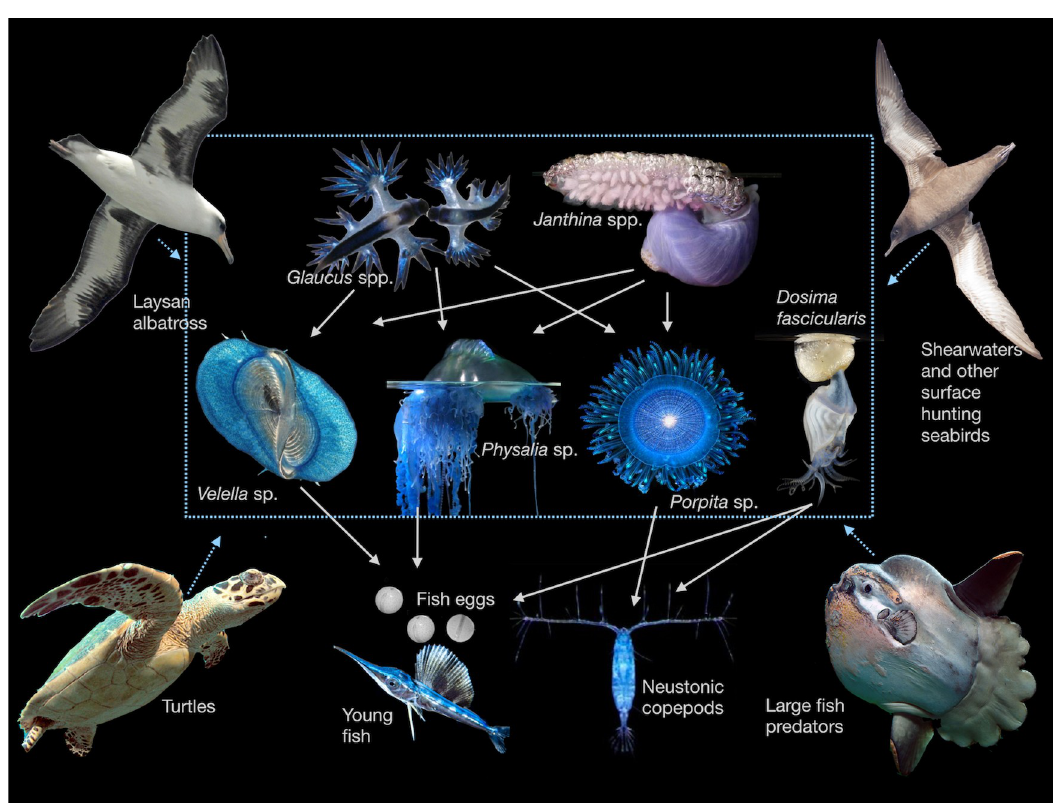
Fig 3. The neuston food web. A simplified surface food web based on [65], with floating species in the grey box, which may be preyed upon similarly by large predators (though see [65,66]for distinguishing features of each species). Images of Mola mola , Laysan albatross, hawksbill sea turtle, and sooty shearwater from Wikimedia Commons. Images of Glaucus marginatus , Janthina umbilicata , Dosima fascicularis , Physalia sp., Velella sp., and Porpita sp. by Denis Riek. Image of copepod from [67], image of fish eggs from [68], image of young sailfish by Linda